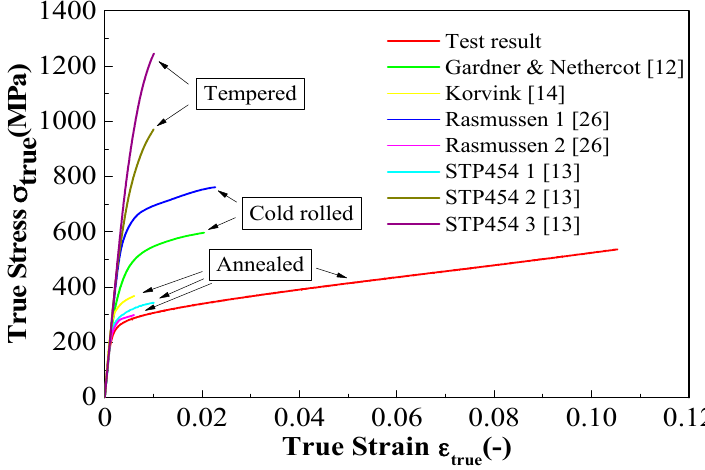
Figure 8. Comparison of compressive test results with the compressive test data in literature.